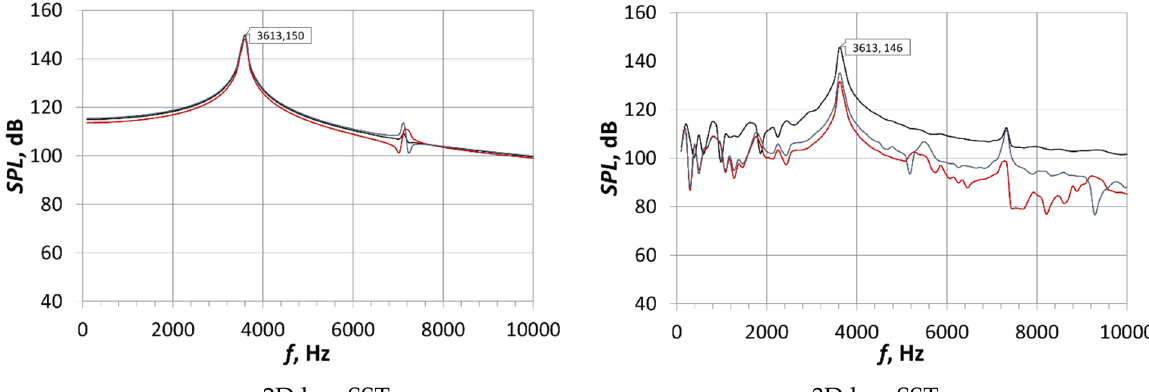
Figure 22. Spectral analysis of SPL for velocity equal to 80 m/s—CFD.